Question: Write a single sentence explaining what this figure depicts.
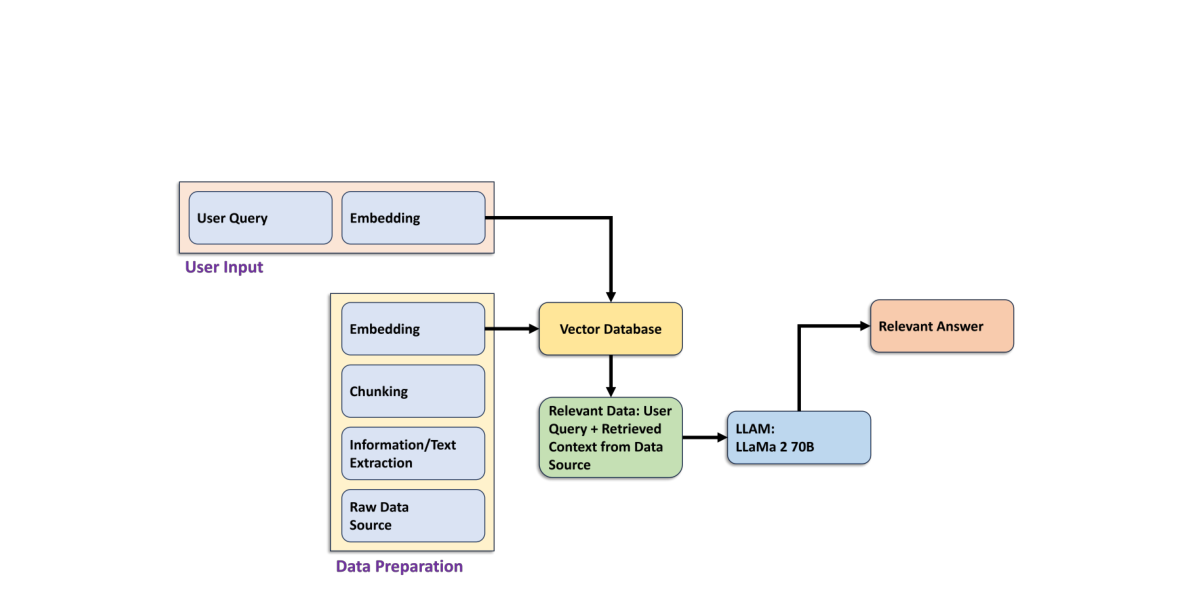
Answer: Retriever-Augmented Generation (RAG) system for SAMCares: Process flowchart for generating context-aware responses using vector embeddings and LLAMA 2 70B model.